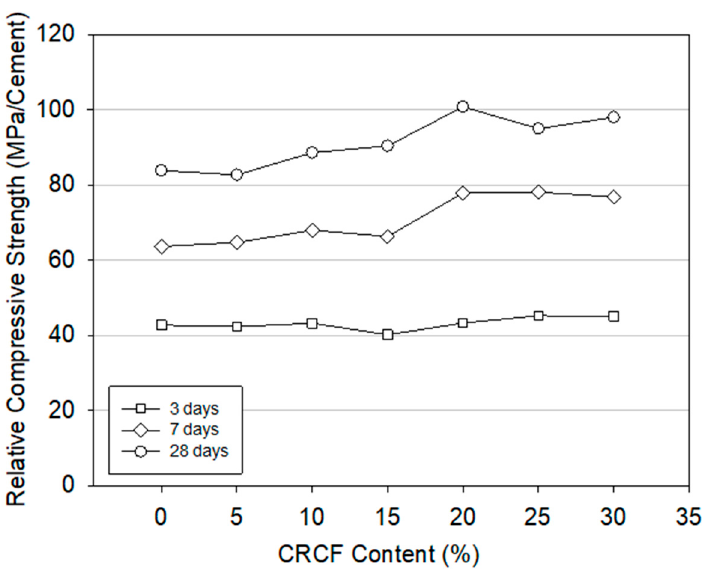
Figure 15. Compressive strength performance of CRCF.